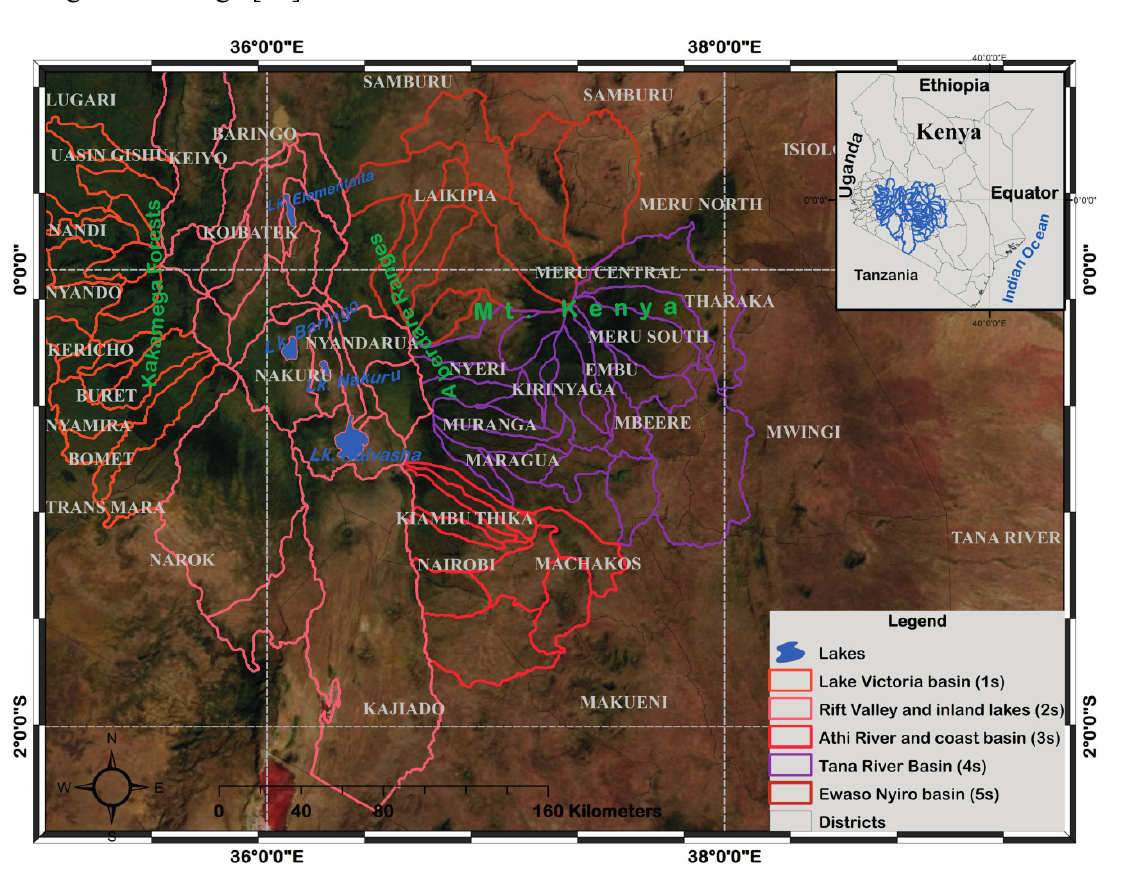
Figure 1. Study area showing the geographical location of the sub-watersheds (within the five main basins in Kenya) and important physical features in central Kenya. Other features include; the equator that crosses the country at 0°0 ′ 00 ″ , and the Indian Ocean